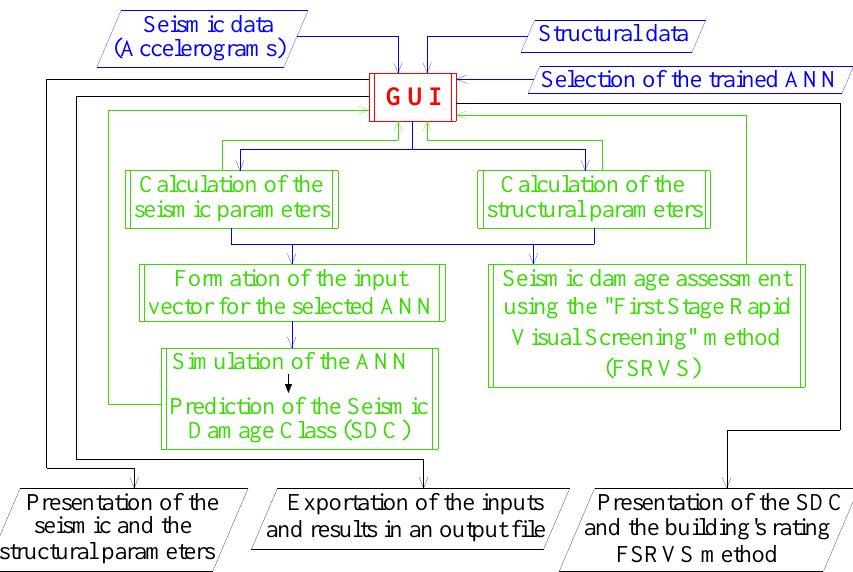
Figure 3. Overview of the developed software application.